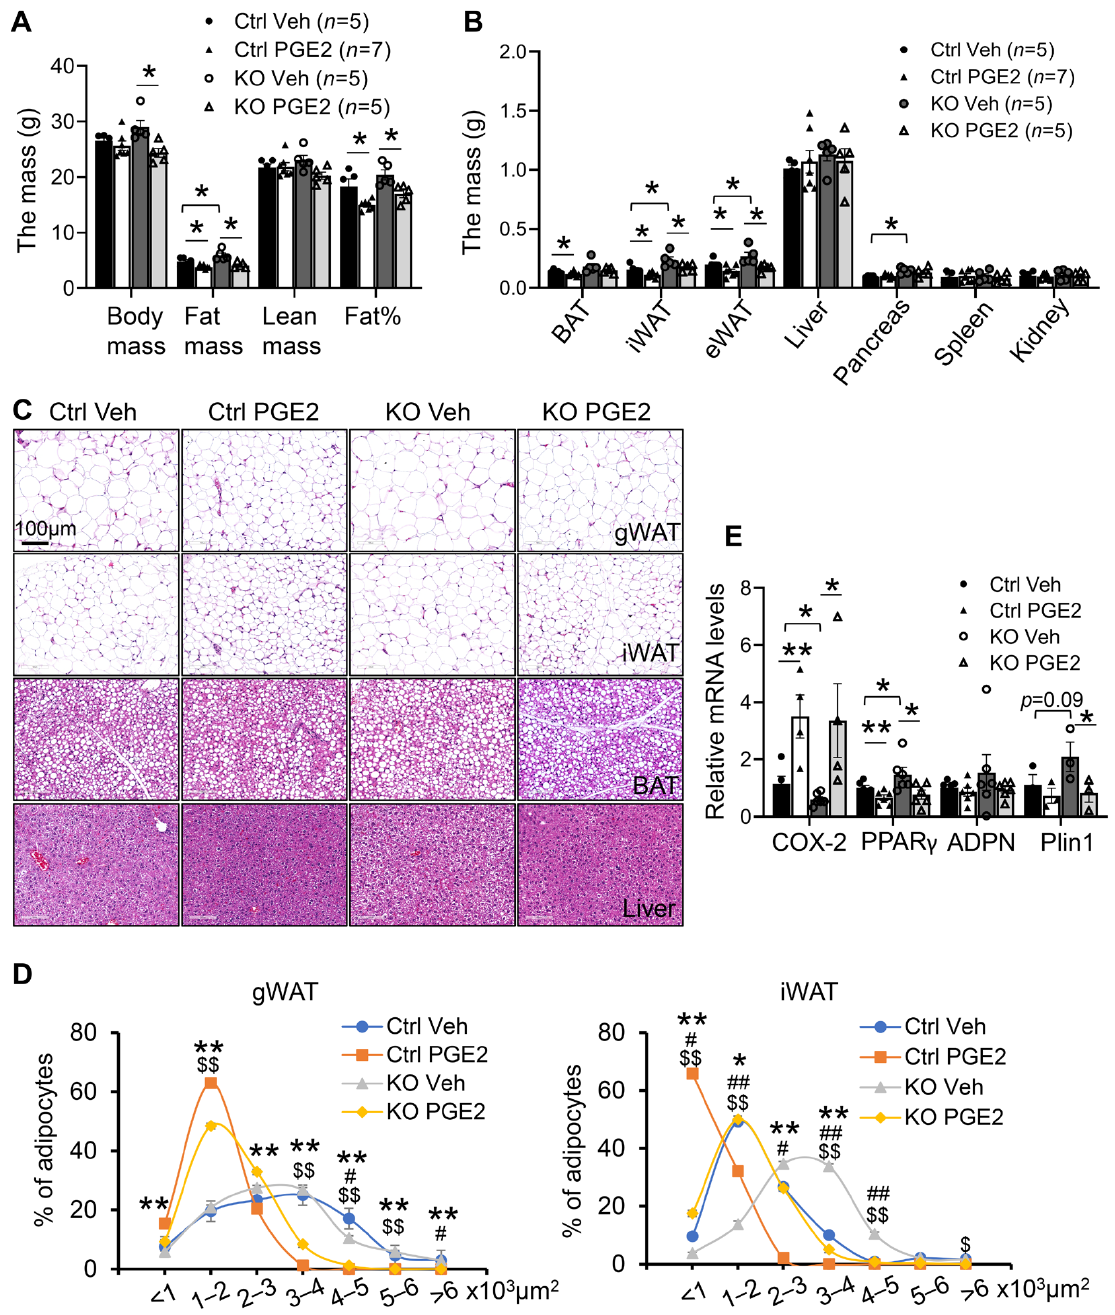
Figure 5. Administration of PGE2 reversed COX-2 KO-induced white adipogenesis in vivo. Six- month-old COX-2 KO mice were injected with PGE2 or vehicle for two weeks. ( A ). PGE2 ad- ministration significantly decreased body mass, fat mass, and fat percentage of COX-2 KO